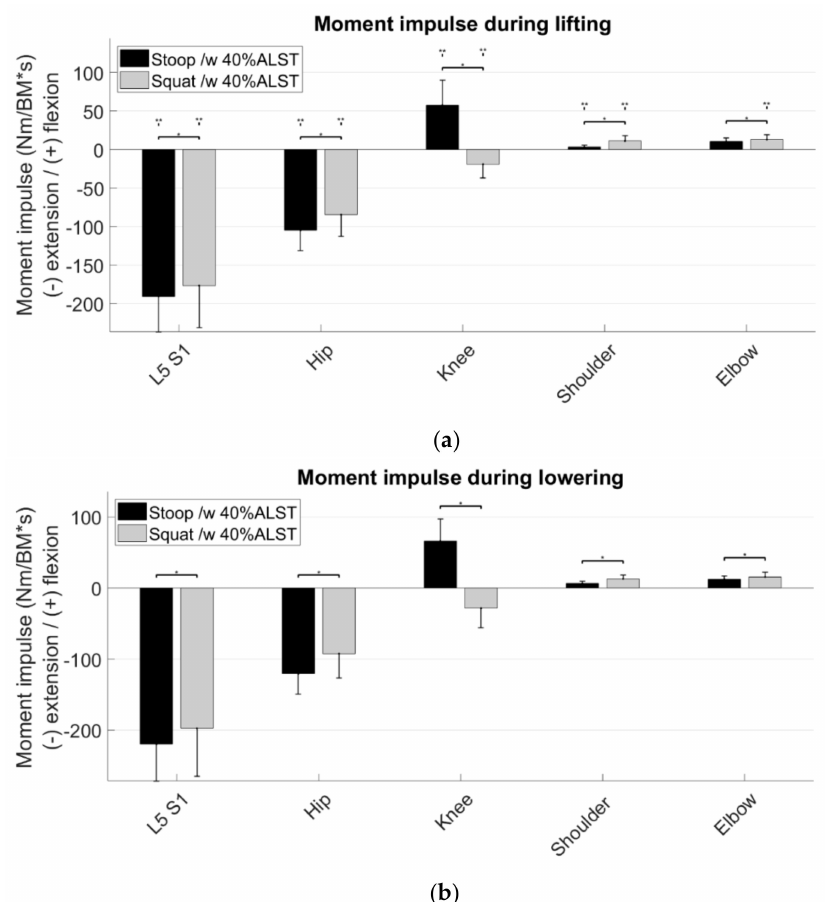
Figure 6. Moment impulse normalized to body mass during the two di ff erent lifting techniques (stoop and squat) with a load equal to 40% of the arm lifting strength test. Statistical significant di ff erences ( α < 0.05) between the handling phases are indicated with three dots, and statistical meaningful di ff erences between technique and loads are indicated with one dot. Error bars indicate standard deviations. ( a ) Moment impulse during the lifting phase in the five di ff erent joints (L5S1, hip, knee, shoulder and elbow); ( b ) moment impulse during the lowering phase in the five di ff erent